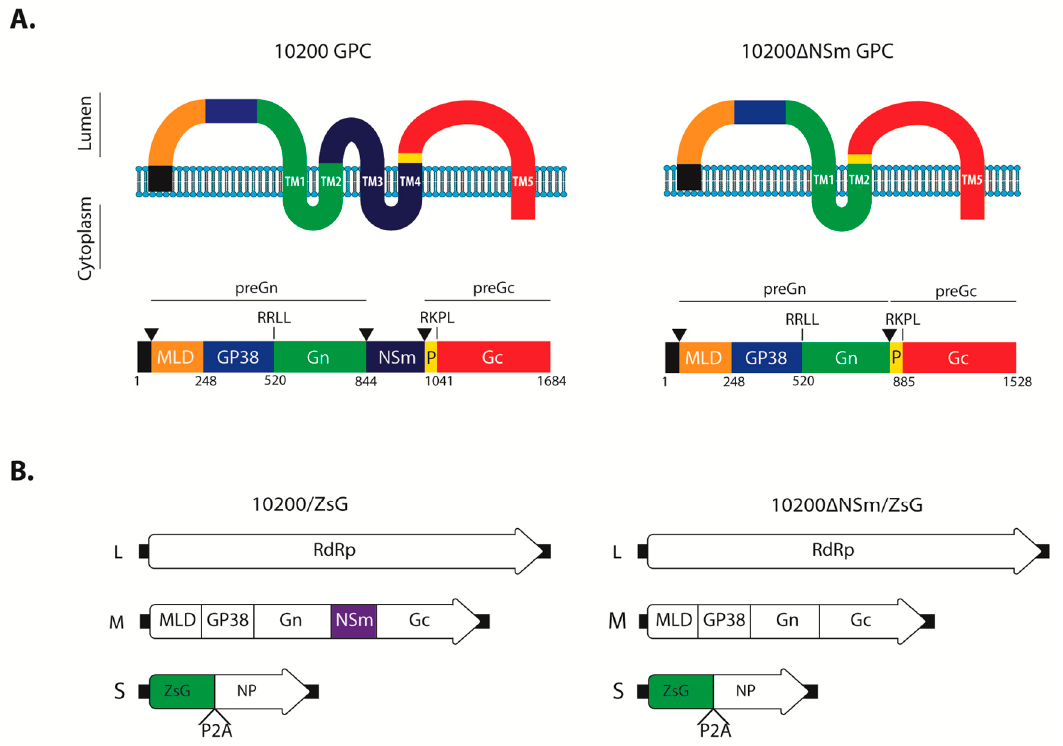
Figure 1. 10200 ∆ NSm / ZsG design. ( A ) Schematic showing the predicted membrane topology of the glycoprotein precursor (GPC) and ∆ NSm mutant encoded by the recombinant M segments of either 10200 / ZsG or 10200 ∆ NSm / ZsG. TM, predicted transmembrane domain; P, ProGc; black triangles, predicted signal peptidase cleavage site; RKLL and RKPL, predicted S1P / SKI-1-like protease cleavage signals. Numbers indicate the first amino acid position of each domain. ( B ) Schematics of Crimean-Congo hemorrhagic fever virus (CCHFV) L (large), M (medium), and S (small) genome segments used to rescue the 10200 / ZsG and 10200 ∆ NSm / ZsG viruses. RdRp, RNA-dependent